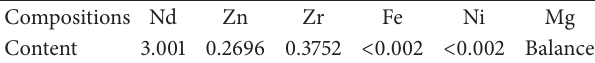
Table 1: Chemical compositions of the NZ30K (weight percent, %). Compositions